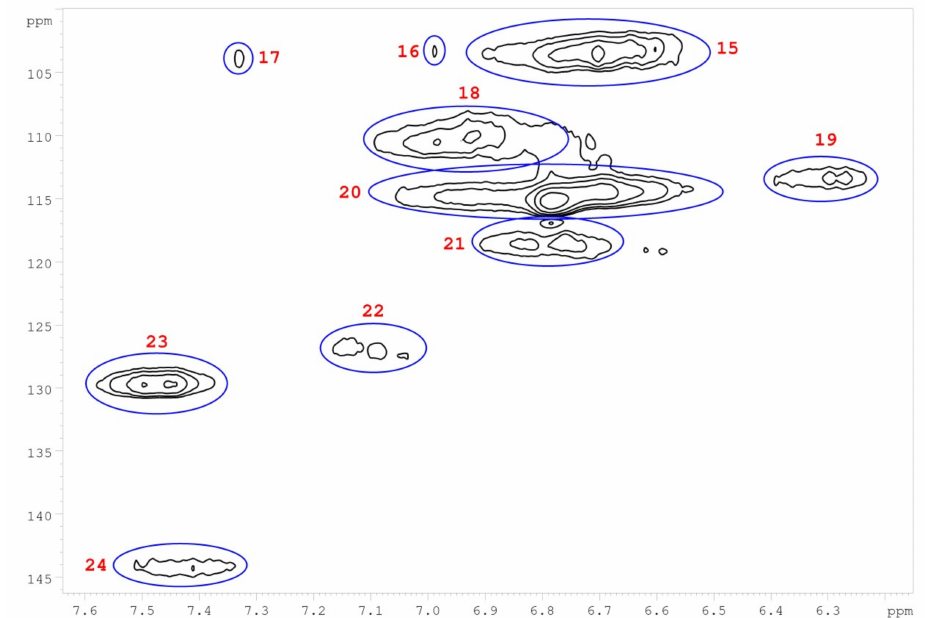
Figure 14. Aromatic HSQC region of a lignin obtained from M. x giganteus stem/leaf mixture (Gig17M). Numbers are listed and assigned in Table